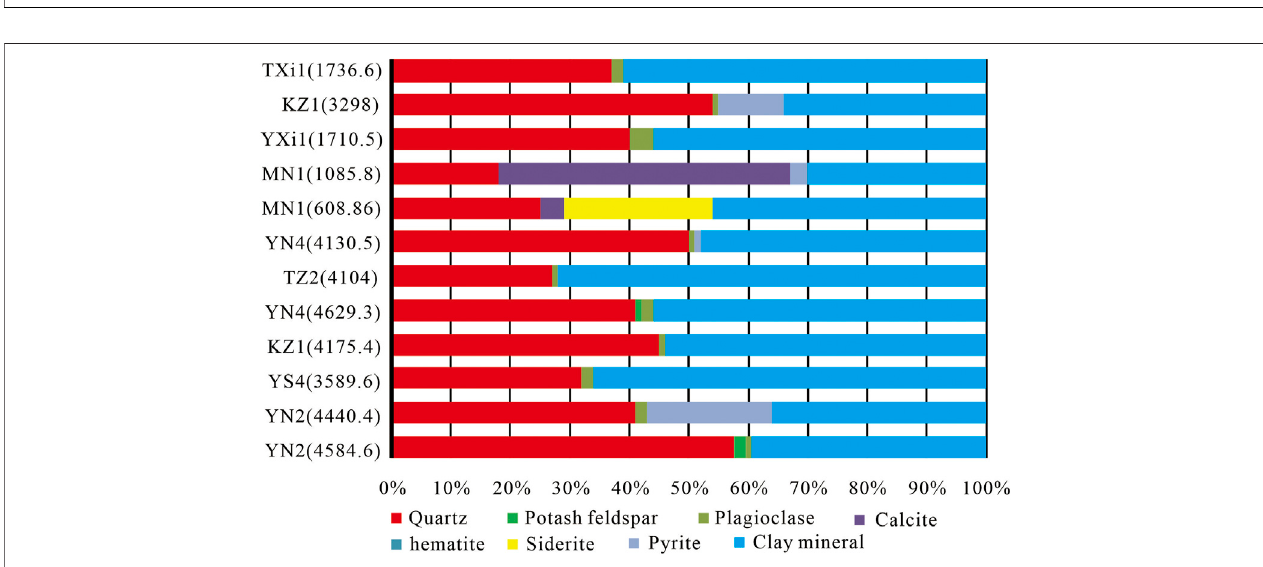
FIGURE 9 | Mineral composition of Lower Jurassic shale in the Tarim Basin.